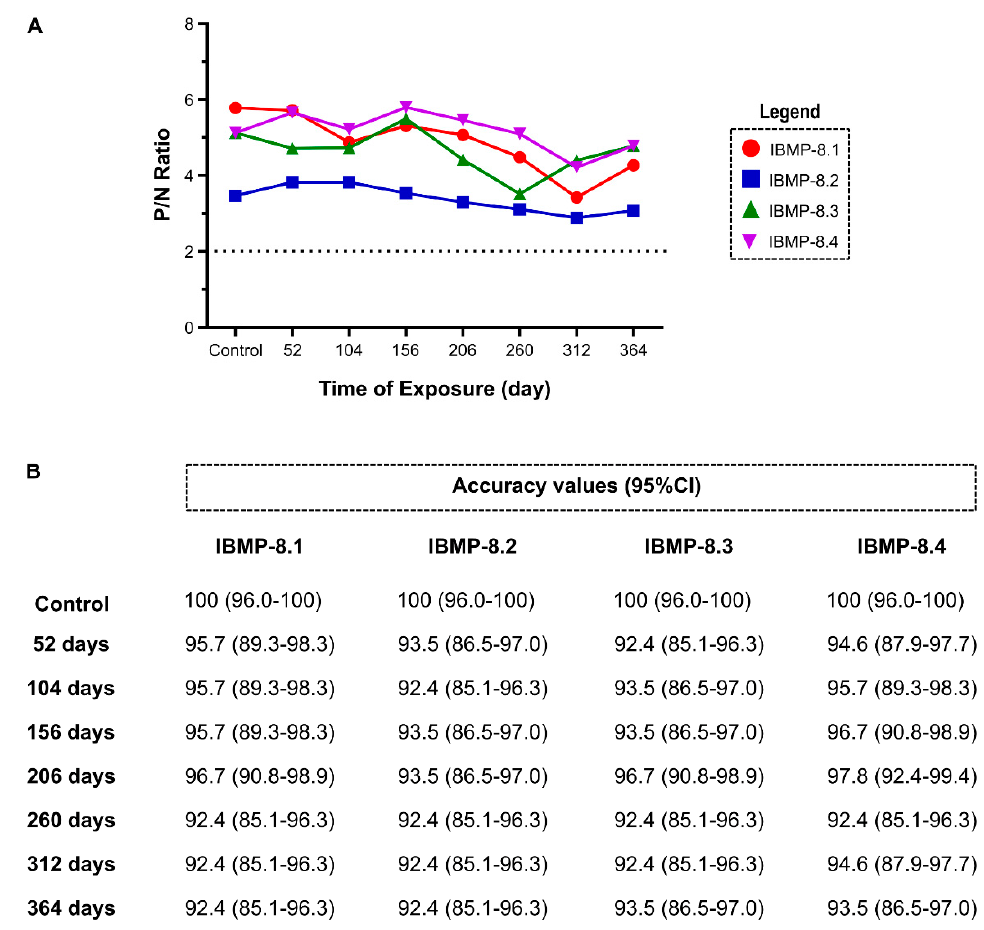
Figure 4. Stability of IBMP chimeric proteins over 1 year. ( A ) Ratio of positive to negative (P/N) serum reactivity in indirect ELISA; ( B ) Accuracy values for each point of analysis.